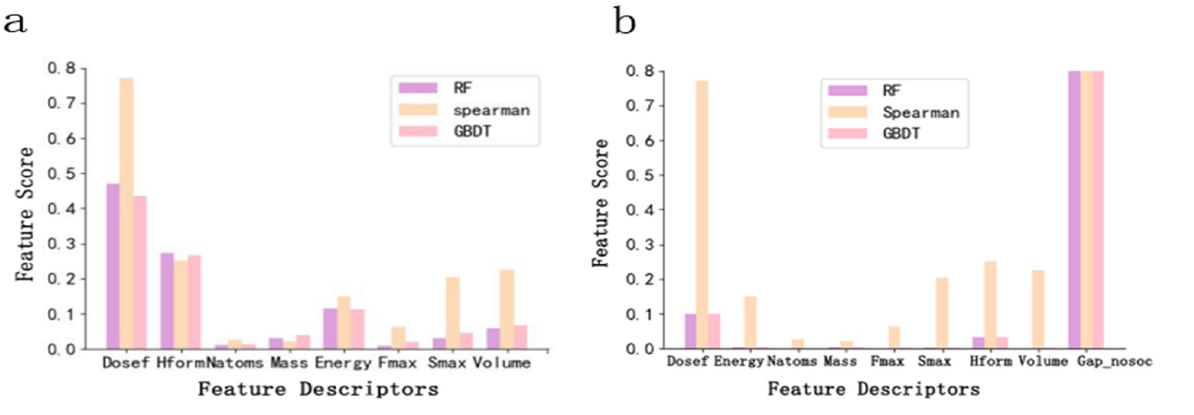
Fig 5. Feature importance evaluation. (a) 8-dimensional feature space (b) 9-dimensional feature space.